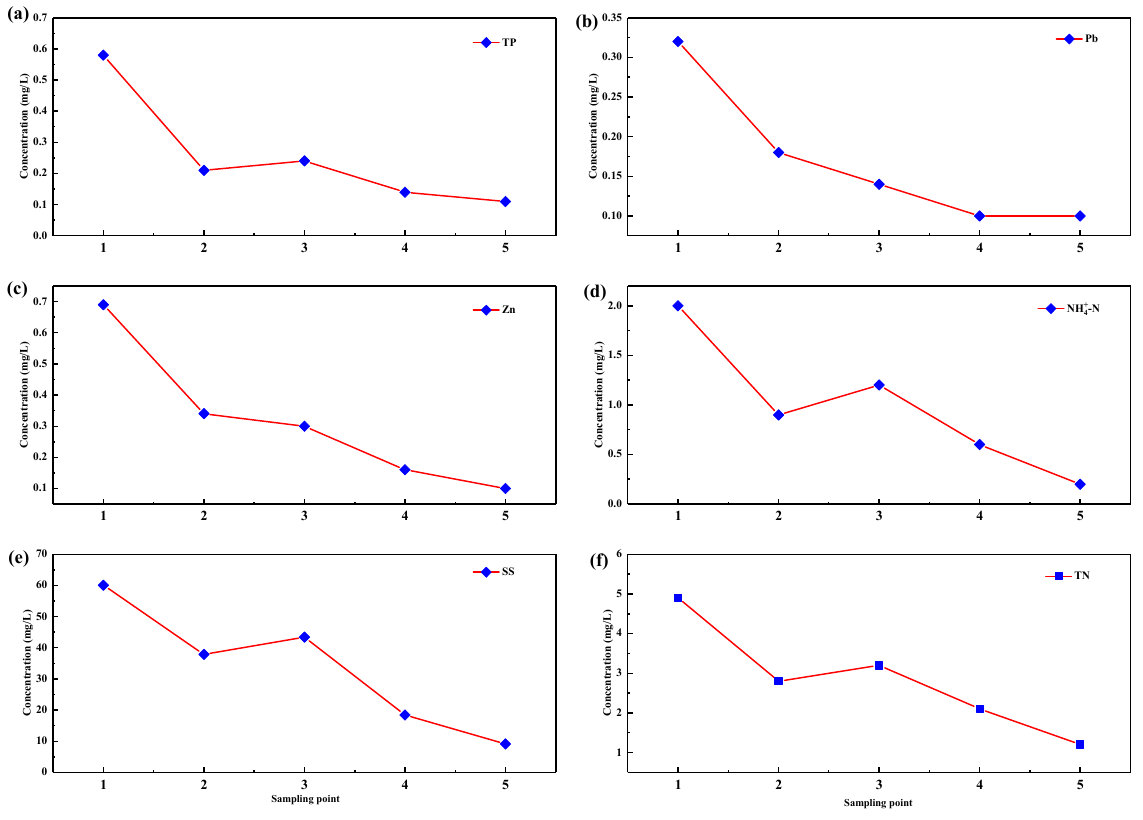
Figure 4. Removal of pollutants across the PBT-GR system. The sampling points 1 to 5 represent the porous asphalt pavement, the bioretention outlet, the storage tank and two sampling points within the hydroponics green roof, respectively. ( a ) suspended solids (SS); ( b ) ammonium nitrogen; ( c ) total nitrogen (TN); ( d ) total phosphorus (TP); ( e ) Pb; ( f ) Zn.